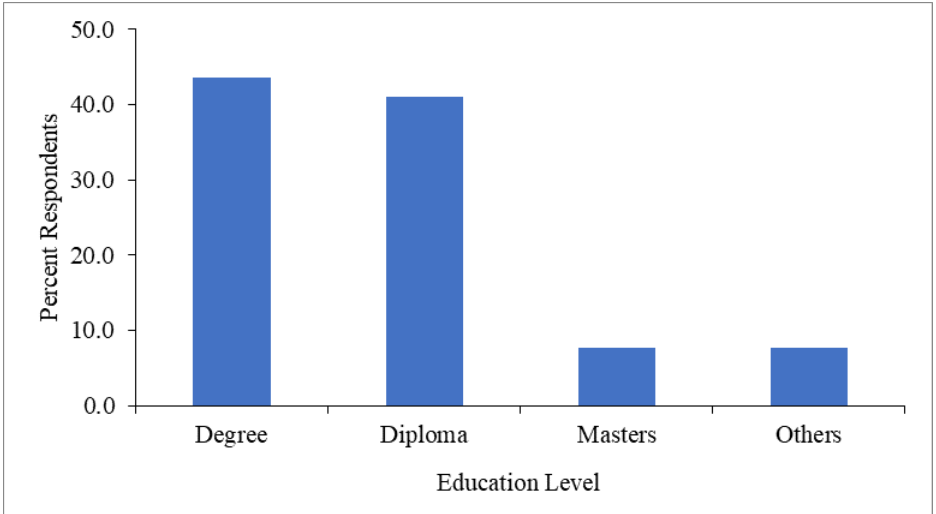
Figure 2. Proportion of respondents with different education qualifications.